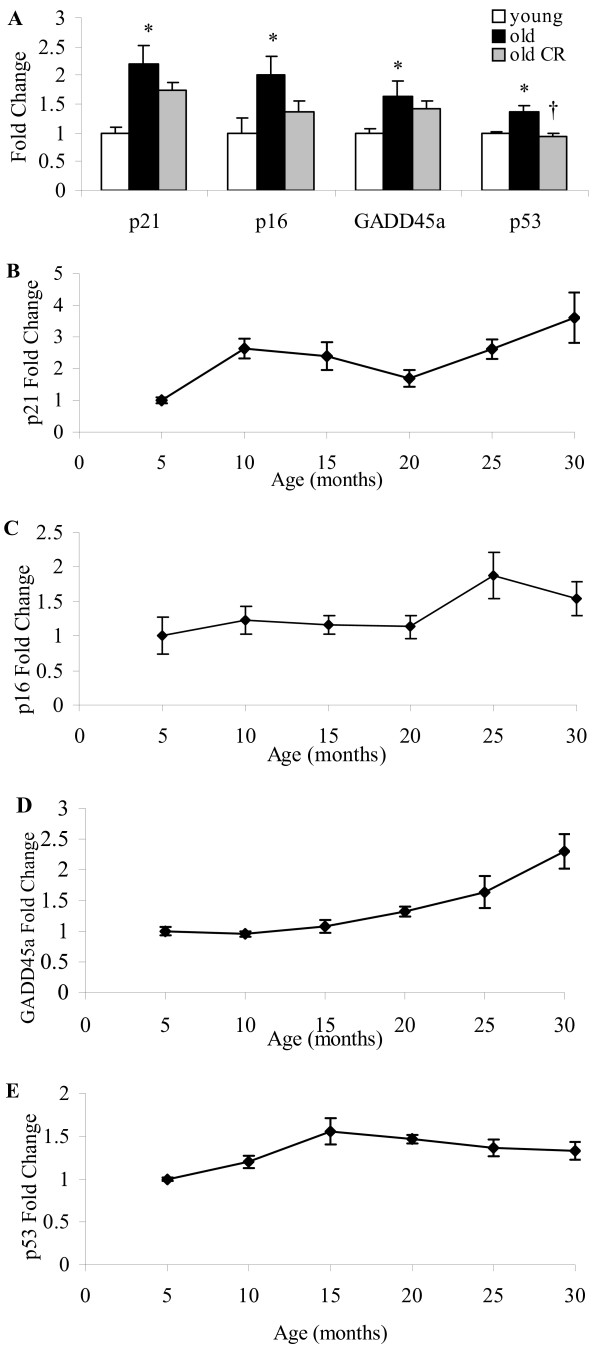
p21, p16, Gadd45a and p53 expression in mouse skeletal muscle. (A) Relative expression ratio ± SE for mRNA levels, as determined by RT-PCR, for p21, p16, Gadd45a and p53 in young (5 month old), old (25 month old), and old CR (n = 5 for each group). (B-E) Relative expression ratio ± SE for mRNA levels for these genes over the course of the adult mouse life span (5 to 30 months of age). The mean of 5 mice ± SE was used for each data point on the graphs. Two-tailed Student's t-test; *P < 0.05 (young versus old) and †P < 0.05 (old verses old CR).